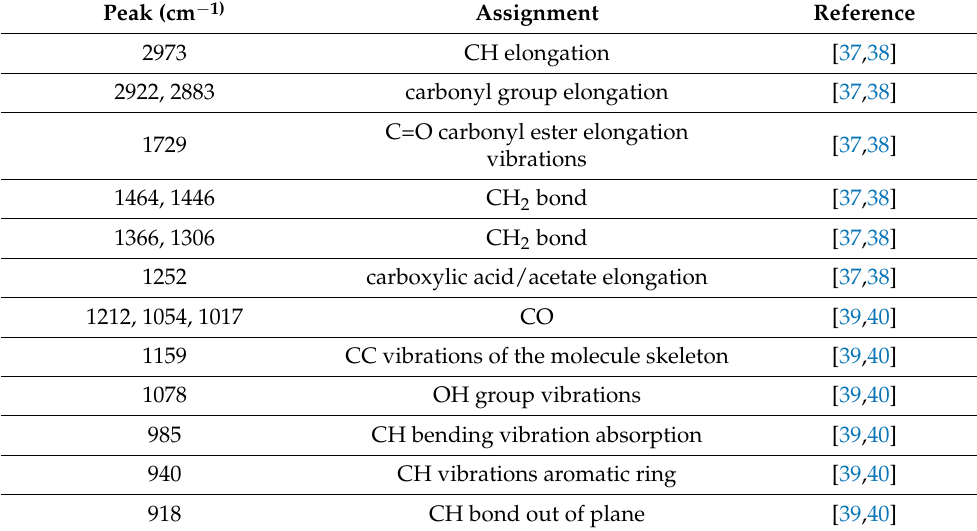
Figure 3. FTIR spectra of cardamomum essential oil and its CNC-stabilized emulsions ( a ) full- spectrum and zoom in the region ( b ) 1800–1425 cm −1 , and of CNF-stabilized emulsions ( c ) full- spectrum and zoom in the region ( d ) 1800–1425 cm −1 . Table 2. Cardamom FTIR characteristic peaks and their respective